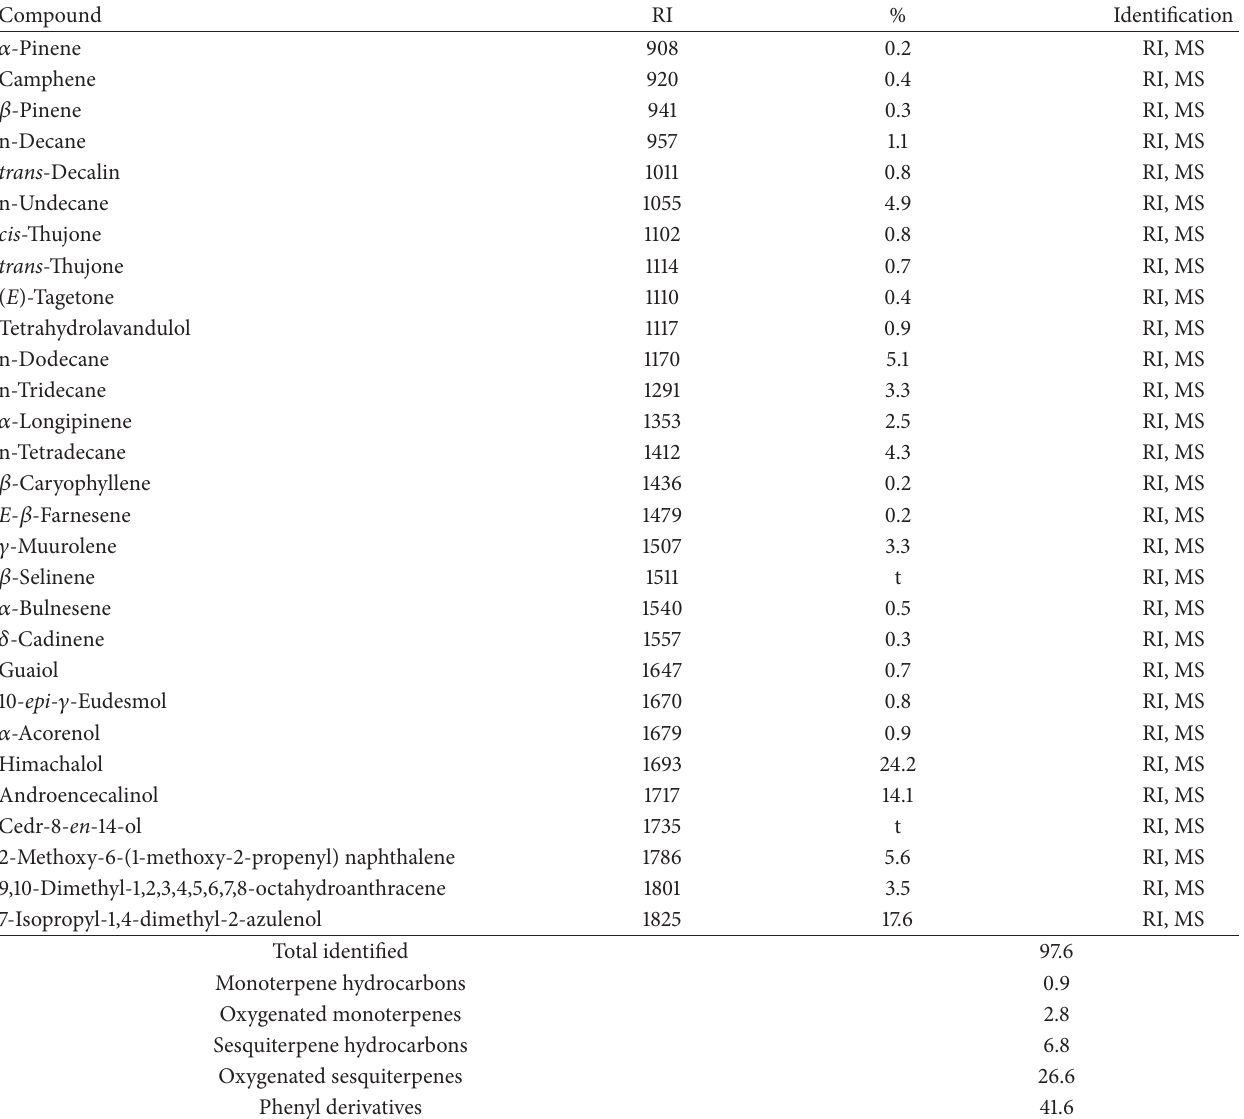
Table 2: Chemical composition of the essential oil of the roots of C. odorata